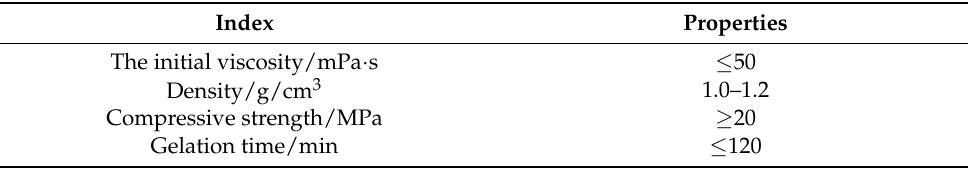
Table 4. Properties of permeable